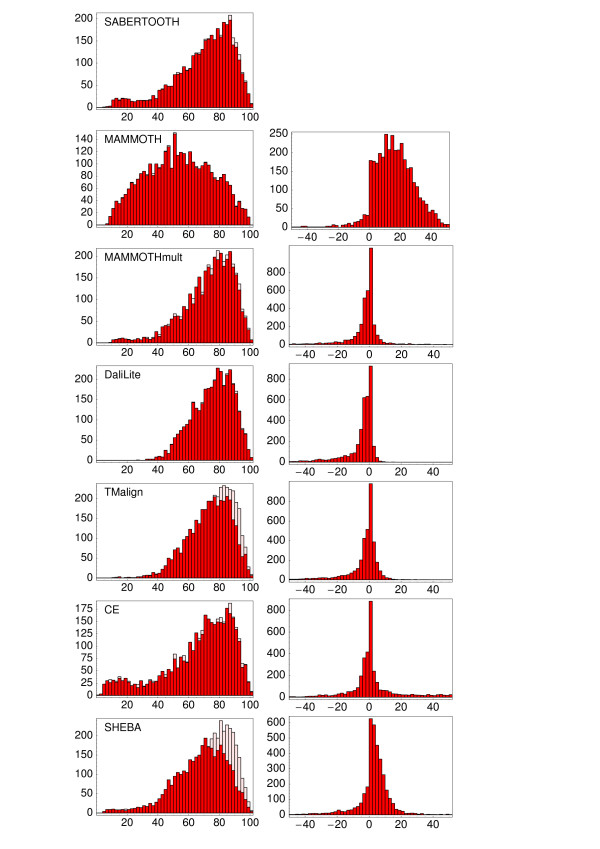
rPSI Comparison Histograms, Differences to SABERTOOTH. In the left column we report the histograms of the rPSI found by the different algorithms over the test set, the PSI (i.e. including short aligned fragments) are shown as shadows. The influence of short fragments is most dramatic for TM-align and SHEBA, as expected from Fig. 7. In the right column, differences to the results of SABERTOOTH are shown for direct comparison. Positive values connote higher rPSI for SABERTOOTH. Mean values may be found in Table 2.